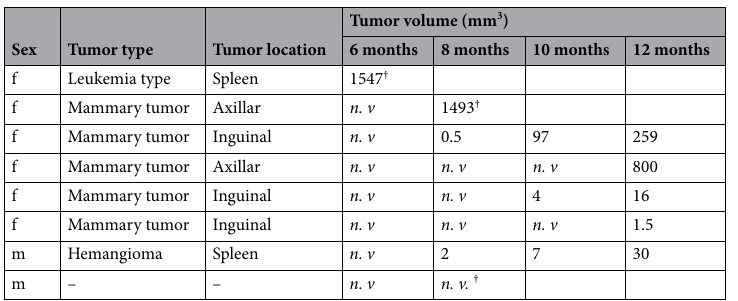
Table 1. Overview of tumors detected during MRI in-vivo monitoring and tumor volumes derived. A male mutant without imaging findings was sacrificed because it had reached the humane endpoint ( n. v. not visible; † end